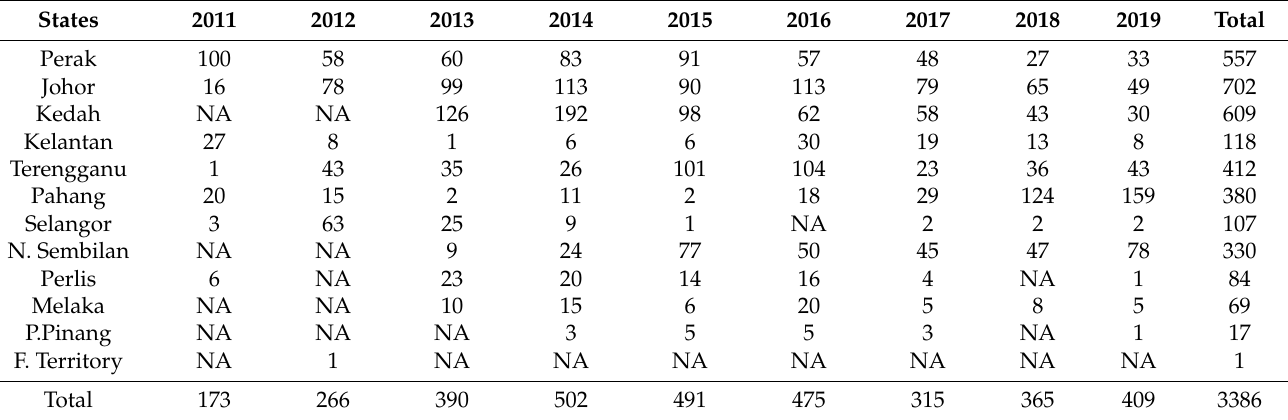
Table 3. Wildlife roadkills in Malaysia from 2011 to 2019.